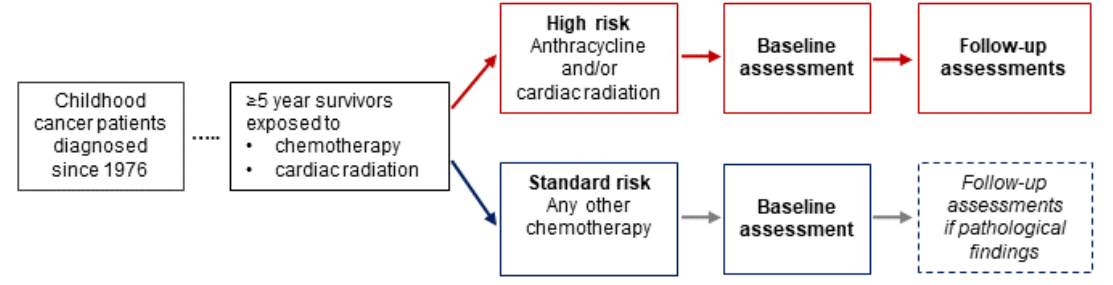
Figure 2. Study design and risk group stratification of childhood cancer